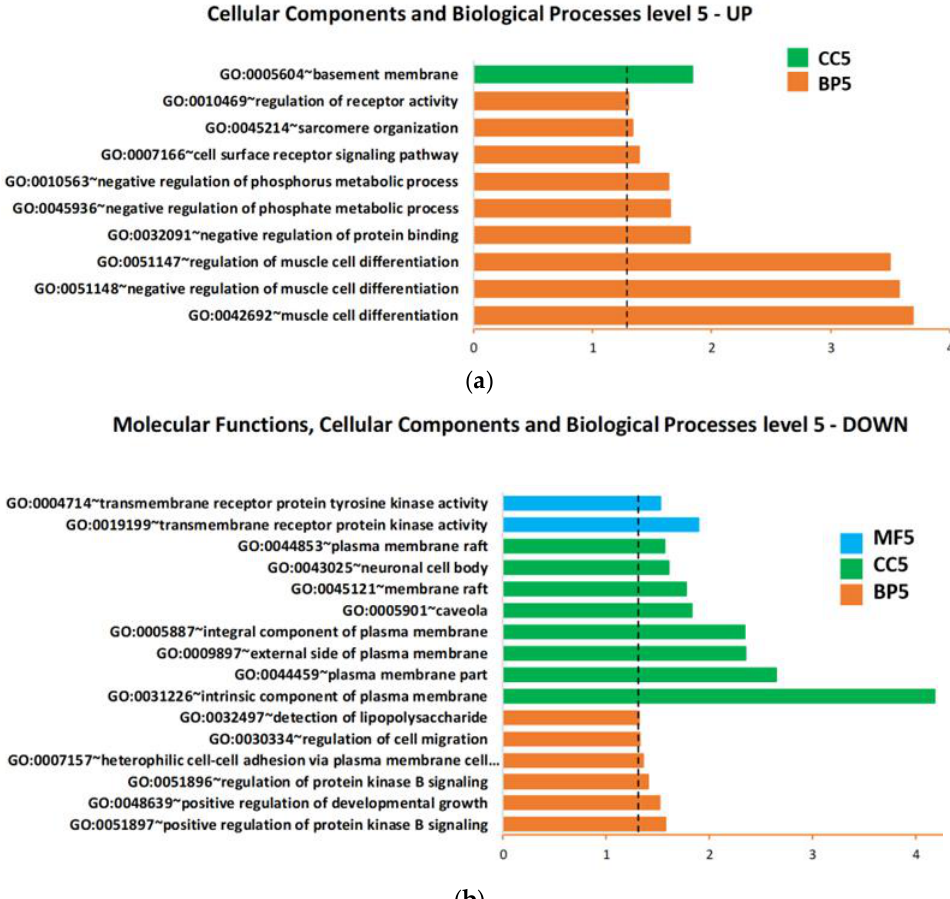
Figure 4. Biological process, cellular component and molecular function enrichment analysis of the lists of deregulated proteins in plasma of ALS patients compared with neurologically healthy controls, carried out using DAVID online tools on ( a ) upregulated proteins and ( b ) downregulated proteins. Enriched terms are plotted in ascending order of statistical significance within every functional category ( p -value < 0.05). Values on the horizontal axis are −log10 ( p -values). Abbreviations: BP = biological processes; CC = cellular components; MF = molecular functions; GO:0007157 heterophilic cell-cell adhesion via plasma membrane cell… = heterophilic cell-cell adhesion via plasma membrane cell adhesion molecules.